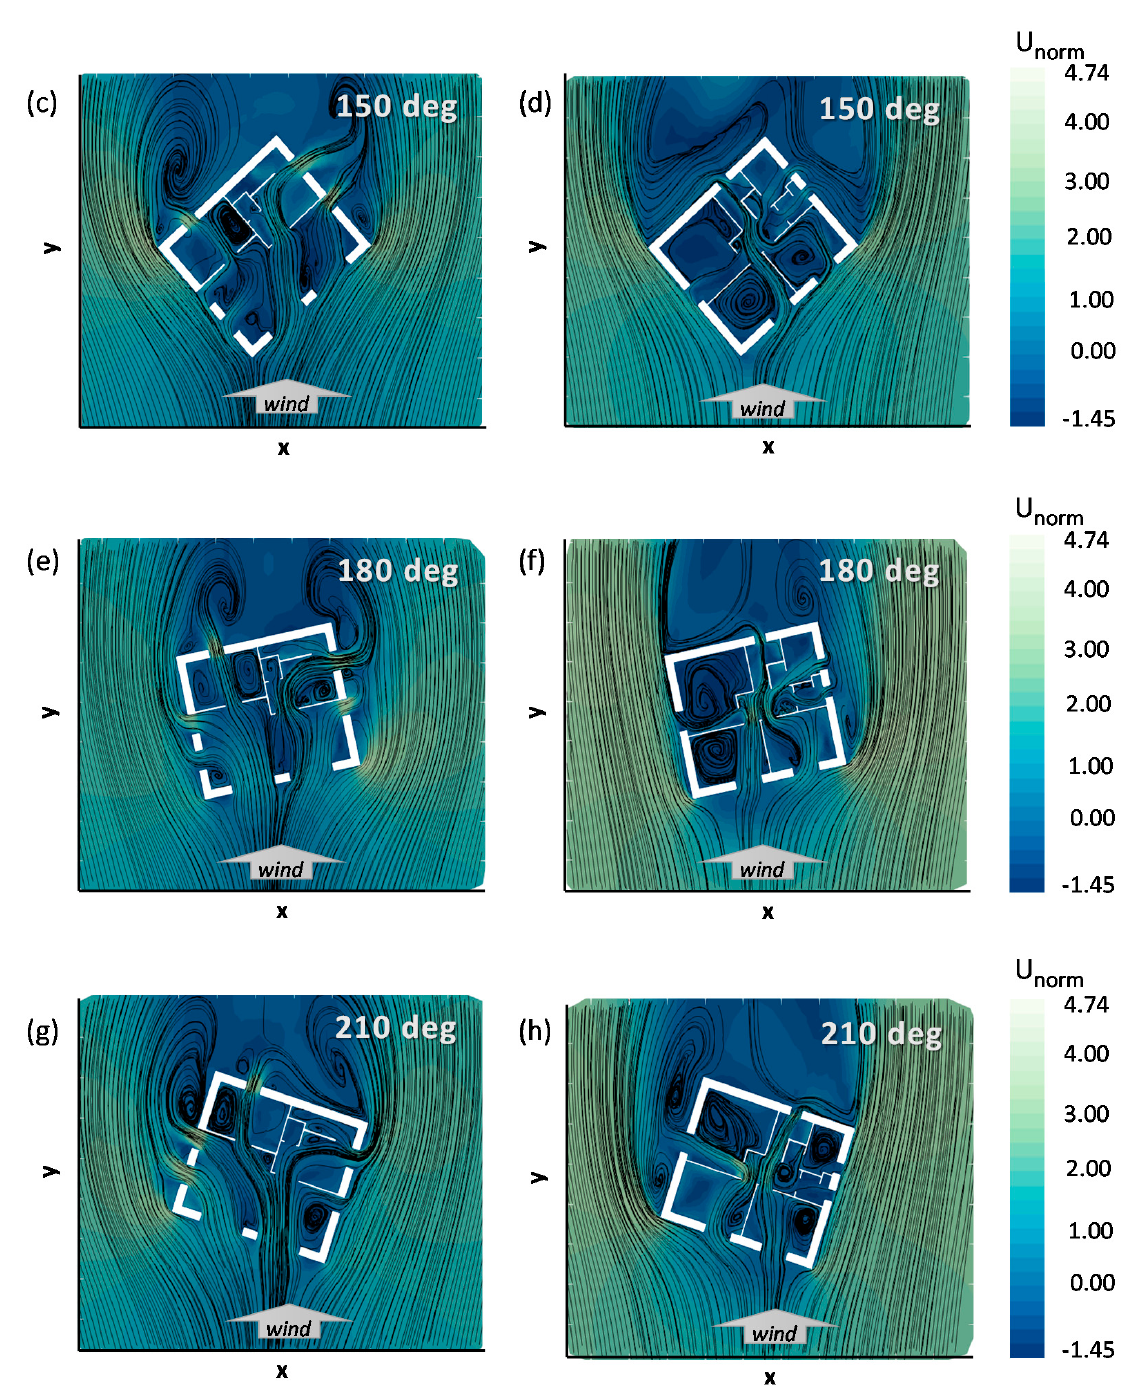
Figure 14. Normalized mean wind speed contours and mean velocity streamlines in horizontal plane (h = 1.2 m above the floor). ( a , b ) 0°; ( c , d ) 150°; ( e , f ) 180°; and ( g , h ) 210° for ground floor ( a , c , e , g ) and first floor ( b , d , f , h ).